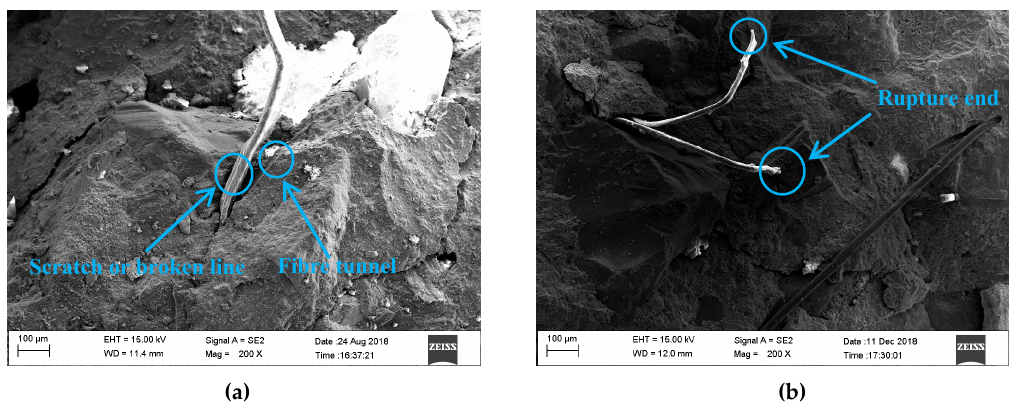
Figure 15. SEM micrographs showing the morphology of PPF after impact: ( a ) Scratch or broken line and fibre tunnel; ( b ) Rupture end.